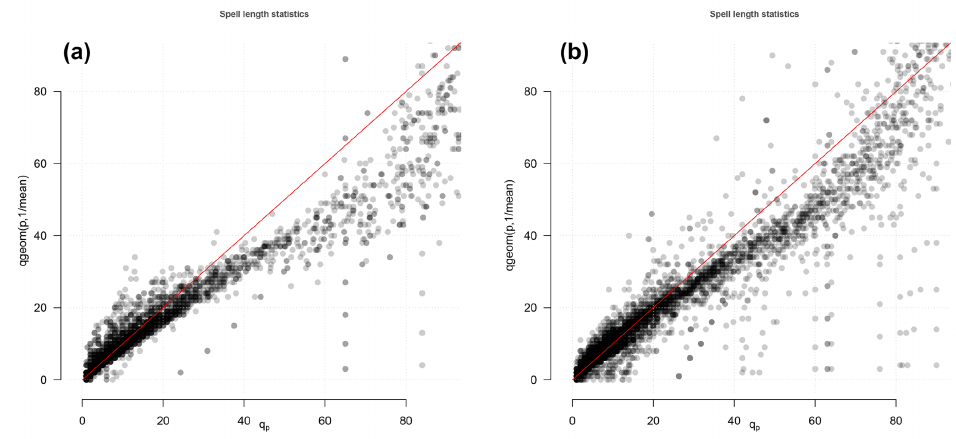
Figure 3. Quantile–quantile plot between the cold (a) and warm (b) spell length and the fitted geometric distribution for the selected ECA&D